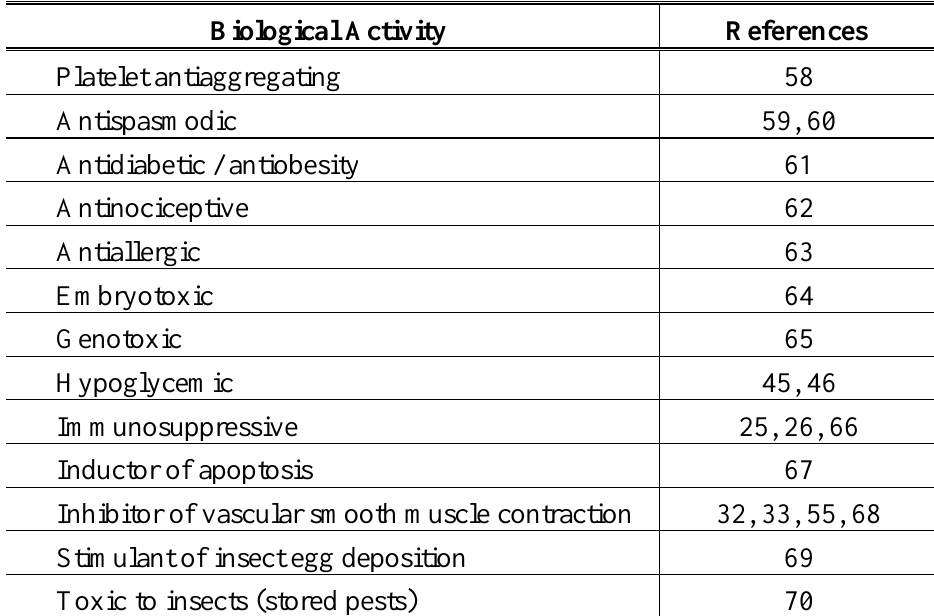
Table 1. Some biological activities described for kaurane diterpenes, published since